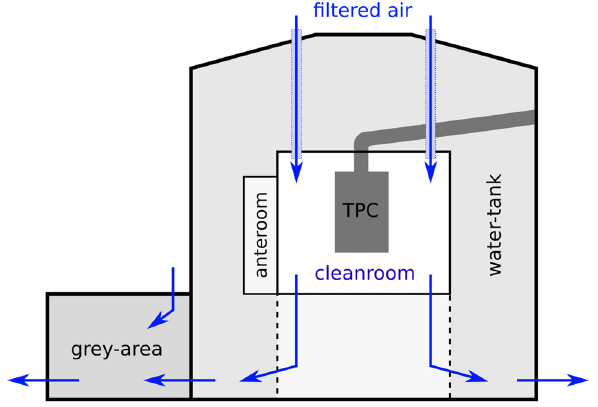
Fig. 4 The UG-CR (ISO 6 class) is built around the cryostat in the center of the water tank. Filtered air is flushed first into the cleanroom in the center and is pushed thereafter through the water tank into the grey area, providing a sequence of decreasing cleanliness levels toward ambient